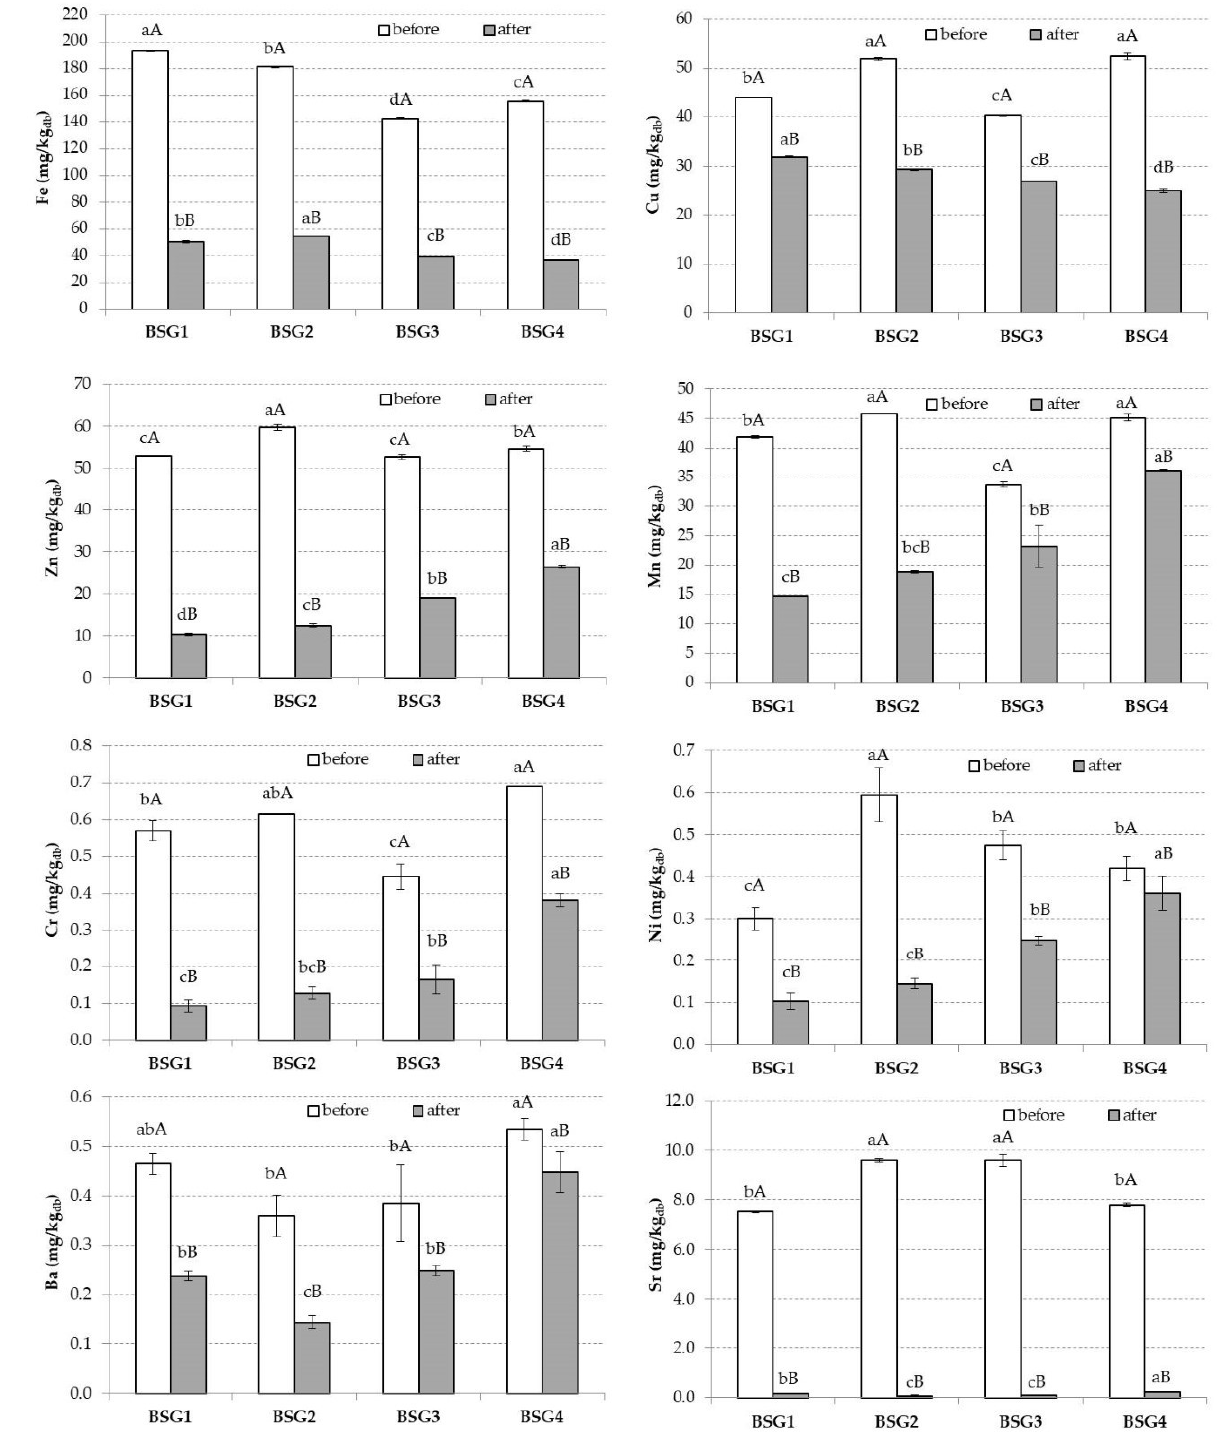
Figure 3. Mean values and standard deviations (error bars) of the micro-mineral (Fe, Cu, Zn, Mn, Cr, Ni, Ba, and Sr) contents in four different brewers’ spent grain (BSG) samples. For each mineral, small letters indicate homogeneous groups established by the ANOVA ( p < 0.05) by comparing BSGs before and after in vitro digestion. For each mineral, capital letters indicate homogeneous groups established by the ANOVA ( p < 0.05) by comparing samples before and after in vitro digestion for each BSG sample. Note: db, dry weight.